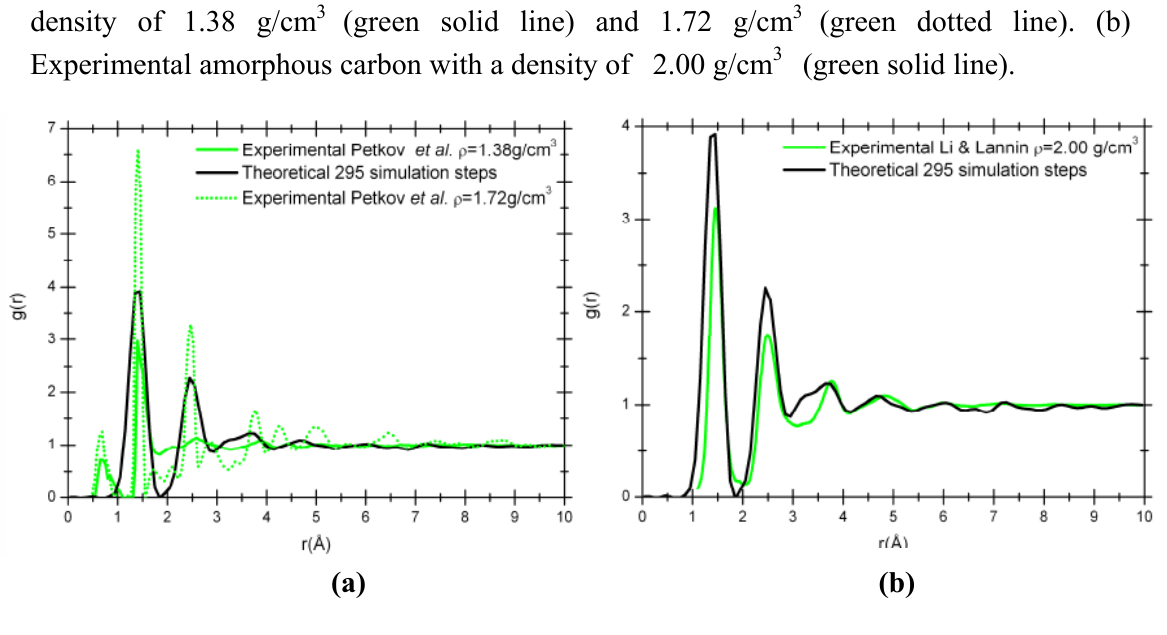
Table 1. Comparison of various parameters associated with densities, first peak positions,coordination numbers and percentage of carbon atoms trigonally